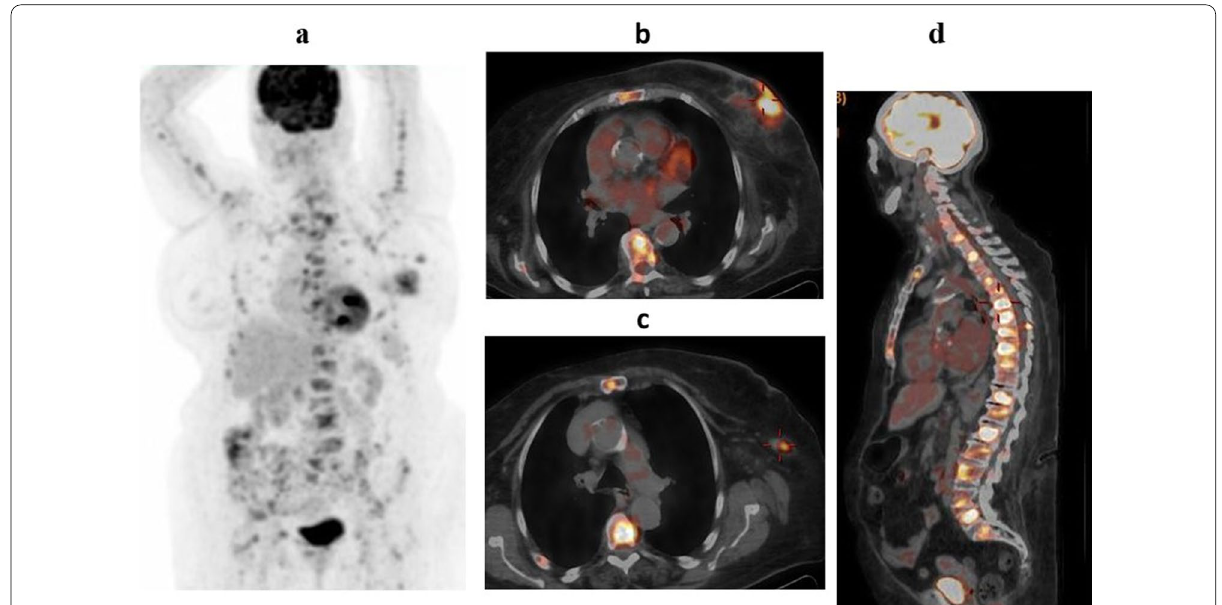
Fig. 2 A female patient aged 84 arrived with newly diagnosed left breast cancer (IDC grade III). a Whole-body PET MIP image revealed active left breast and left axillary lesions with other innumerable skeletal active lesions. b Axial fused PET/CT picture revealed an ill-defined irregular metabolically active left breast retroareolar soft tissue mass lesion with maximal axial dimensions of 43 25 mm and SUVmax of up to 7.33, coupled × with modest overlaying skin thickening and surrounding architectural distortion. c Axial fused PET/CT image revealed enlarged metabolically active left axillary lymph node, measuring 11 7.5 mm and achieving up to 5.19 SUVmax. d Sagittal fused PET/CT image revealed innumerable × hypermetabolic osseous lesions at the spine, achieving up to 10.41